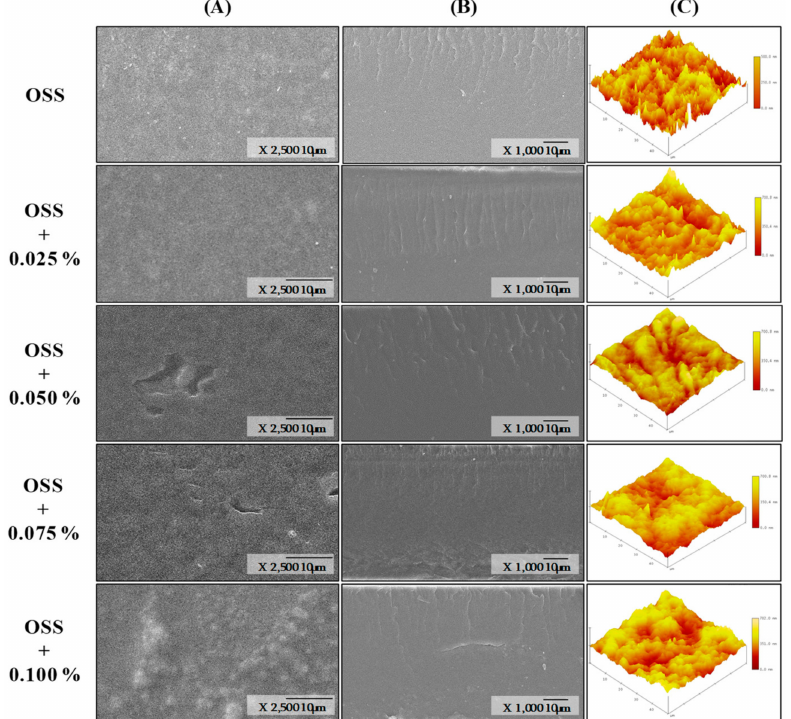
Figure 5. Scanning electron micrographs of octenyl succinate starch films with hazelnut skin extract, surface ( A ), cross-section ( B ), and surface topography ( C ) OSS: Octenyl succinate